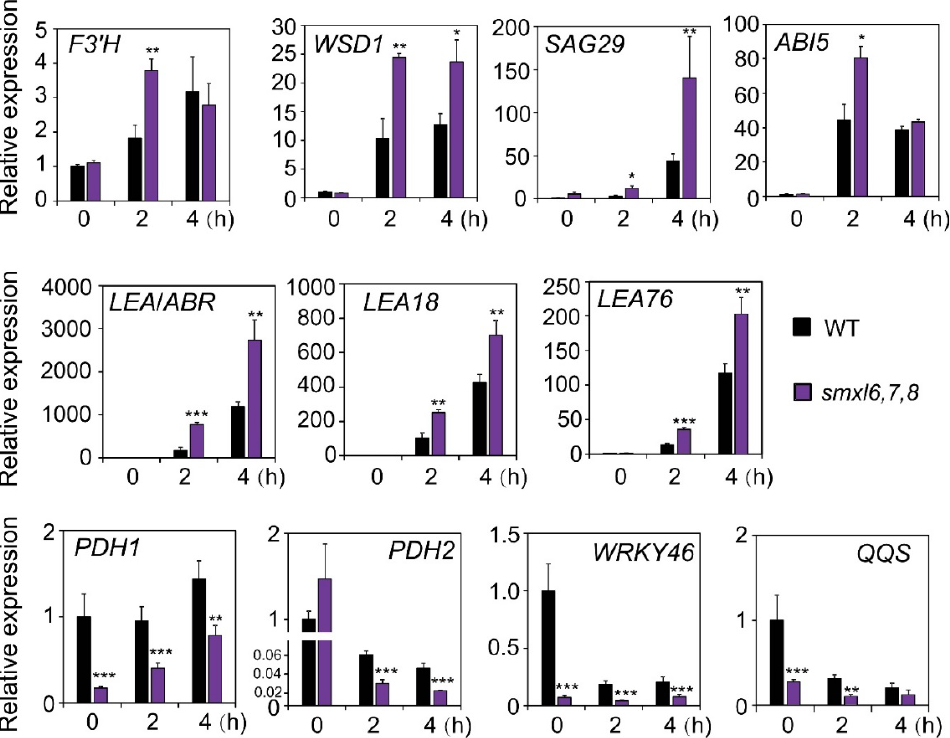
Figure 6. Expression patterns of several marker genes related to several drought resistance-associated traits in smxl6 , 7 , 8 mutant and wild-type (WT) plants under normal and dehydration conditions. Rosette leaves of 24-day-old soil-grown plants were used for qRT-PCR analysis. Relative transcript levels were normalized to a value of 1 in the non-dehydrated WT. Data shown are means and standard errors ( n = 3 biological replicates). Asterisks show significant differences between the smxl6,7,8 mutant and WT plants in the same treatment condition (Student’s t -test; * p < 0.05; ** p < 0.01 and *** p < 0.001).